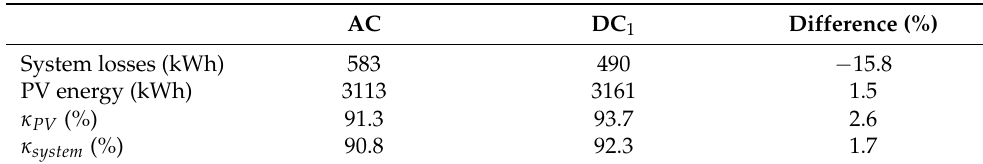
Table 3. Comparison of system performance with AC and DC 1 with 3.7 kWp PV and 7.5 kWh battery